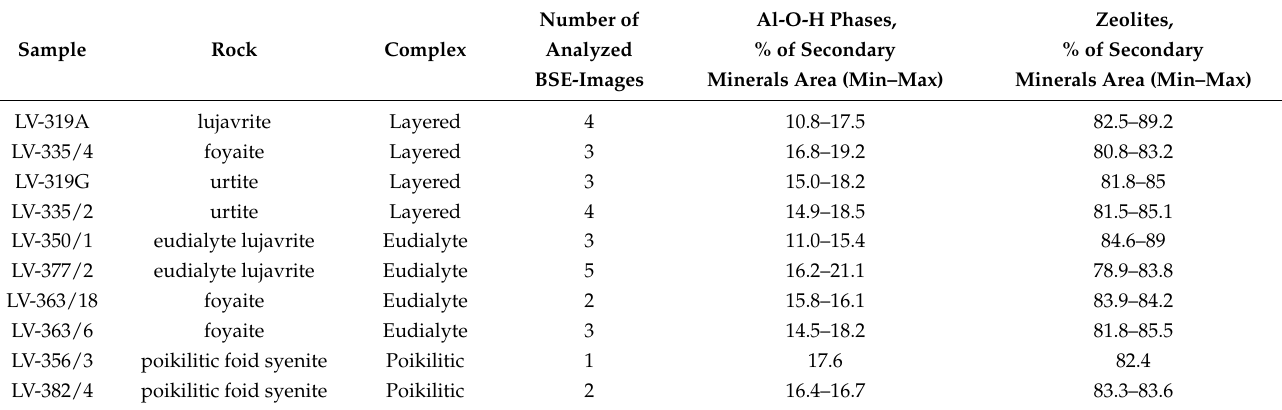
Table 7. Results of measurements of areas occupied by nepheline alteration products.